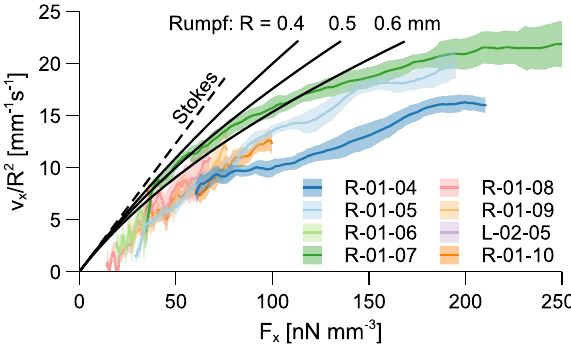
Fig. 3 Scaled bubble velocities as a function of the horizontal magnetic force. Results are compared with Eqs. (9) and (10) during the 4.7 s microgravity fl ight. The legend indicates the bubble ID from Table 2.